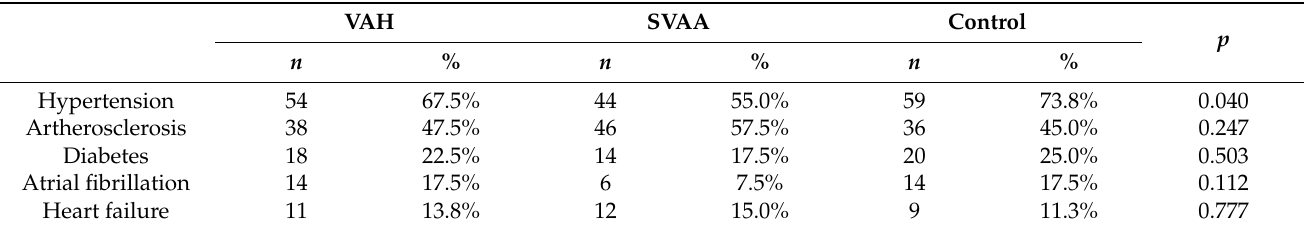
Table 4. Frequency of comorbidities.